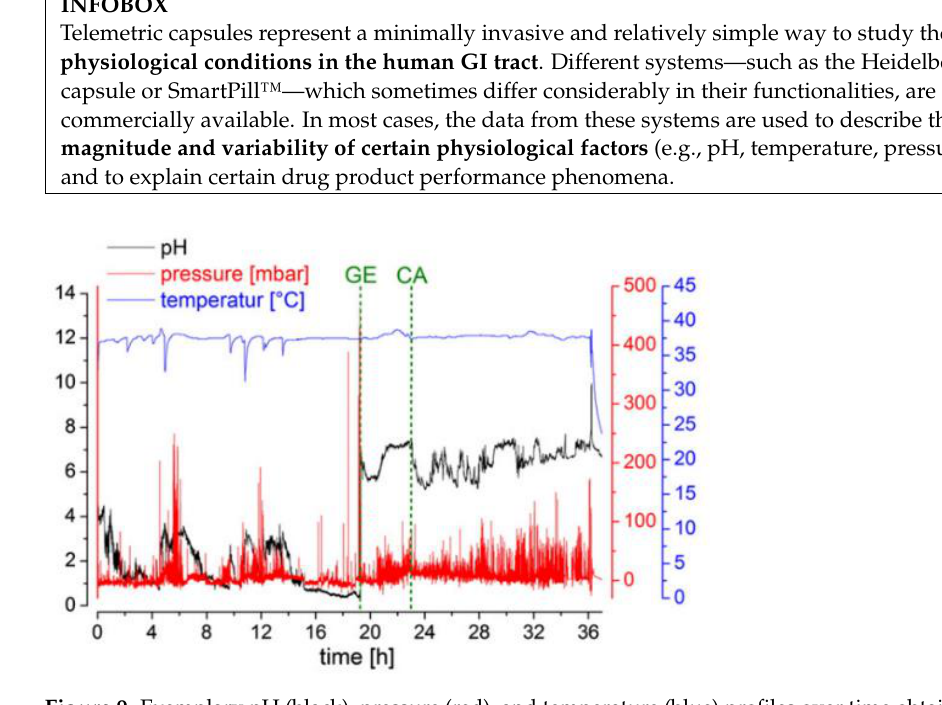
Figure 9. Exemplary pH (black), pressure (red), and temperature (blue) profiles over time obtained after SmartPill TM administration in a fed state in a healthy volunteer (GE—gastric emptying, CA—colonic arrival). Reproduced with permission from Journal of Controlled Release , 220, Koziolek et al., “Intragastric pH and pressure profiles after intake of the high-caloric, high-fat meal as used for food effect studies”, 71–78, [49], Copyright Elsevier